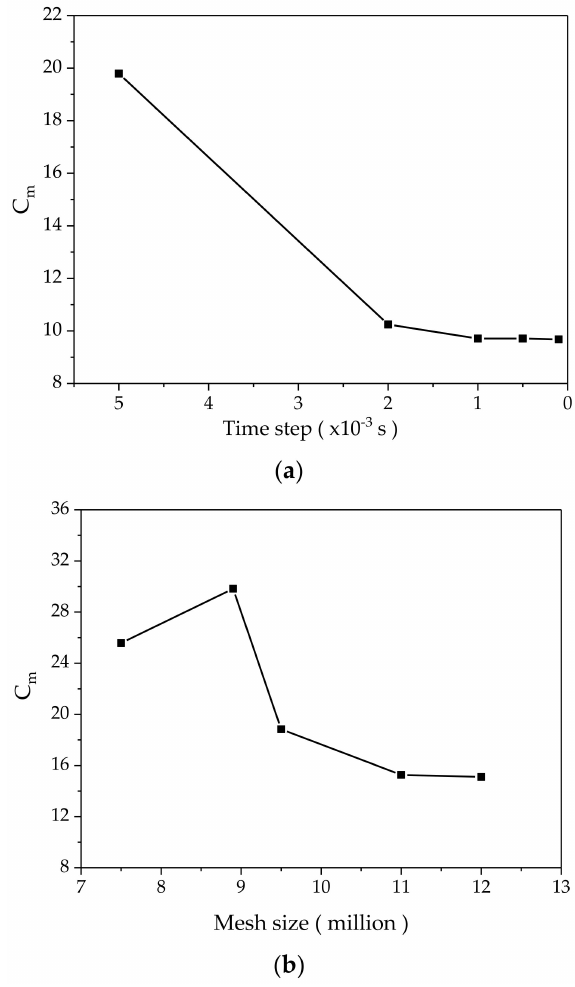
Figure 4. Independence study results: ( a ) the time step and ( b ) the mesh